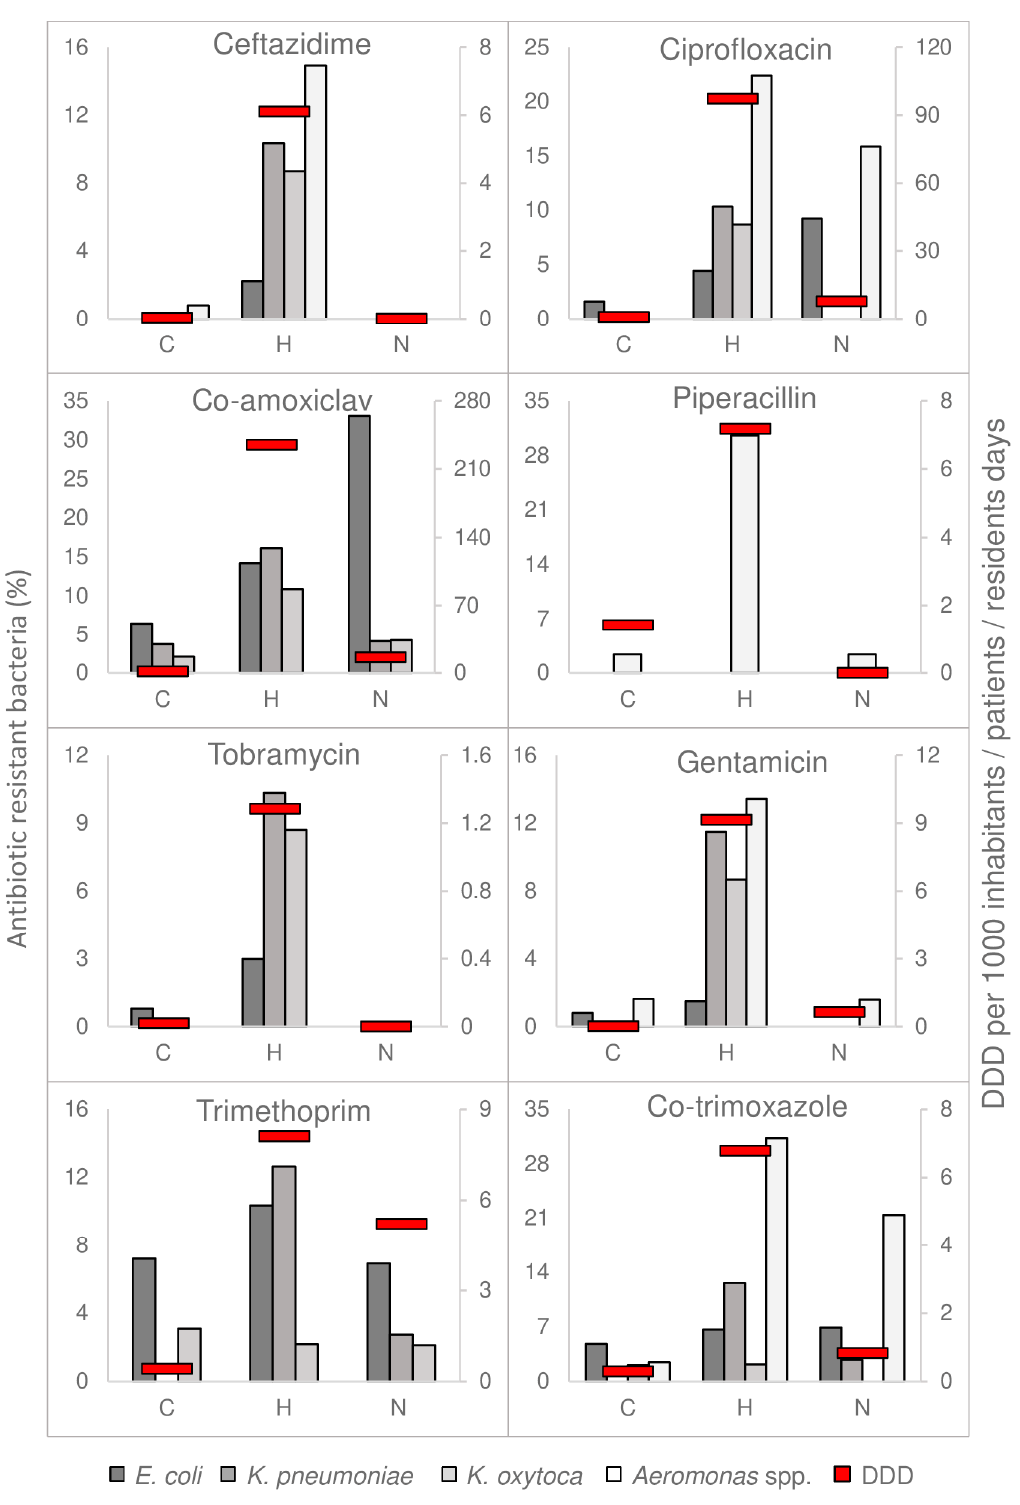
Figure 2. Antimicrobial consumption versus resistance. The antimicrobial consumption in daily defined dose (DDD) per 1000 inhabitant / patient / resident-days is shown as red bars. The grey bar plots represent the percentage of antimicrobial resistant bacteria measured in the wastewater. C = community, H = hospital, and N = nursing home (N). Meropenem (not shown) was only used in the hospital, although at low amounts (0.47 DDD / 1000 patient-days). All bacterial isolates were susceptible to meropenem.